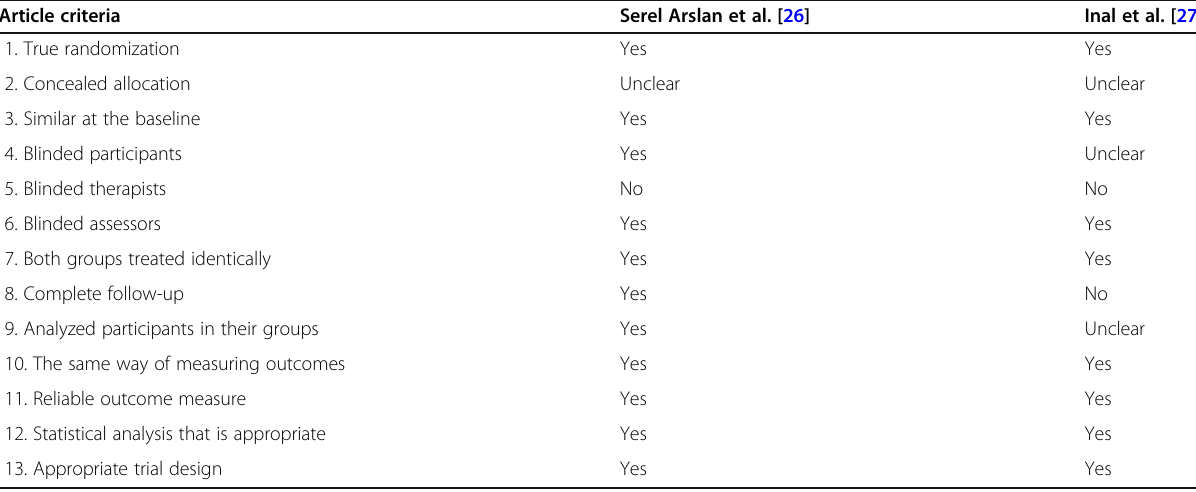
Table 4 Critical appraisal for randomized controlled trials: JBI Article